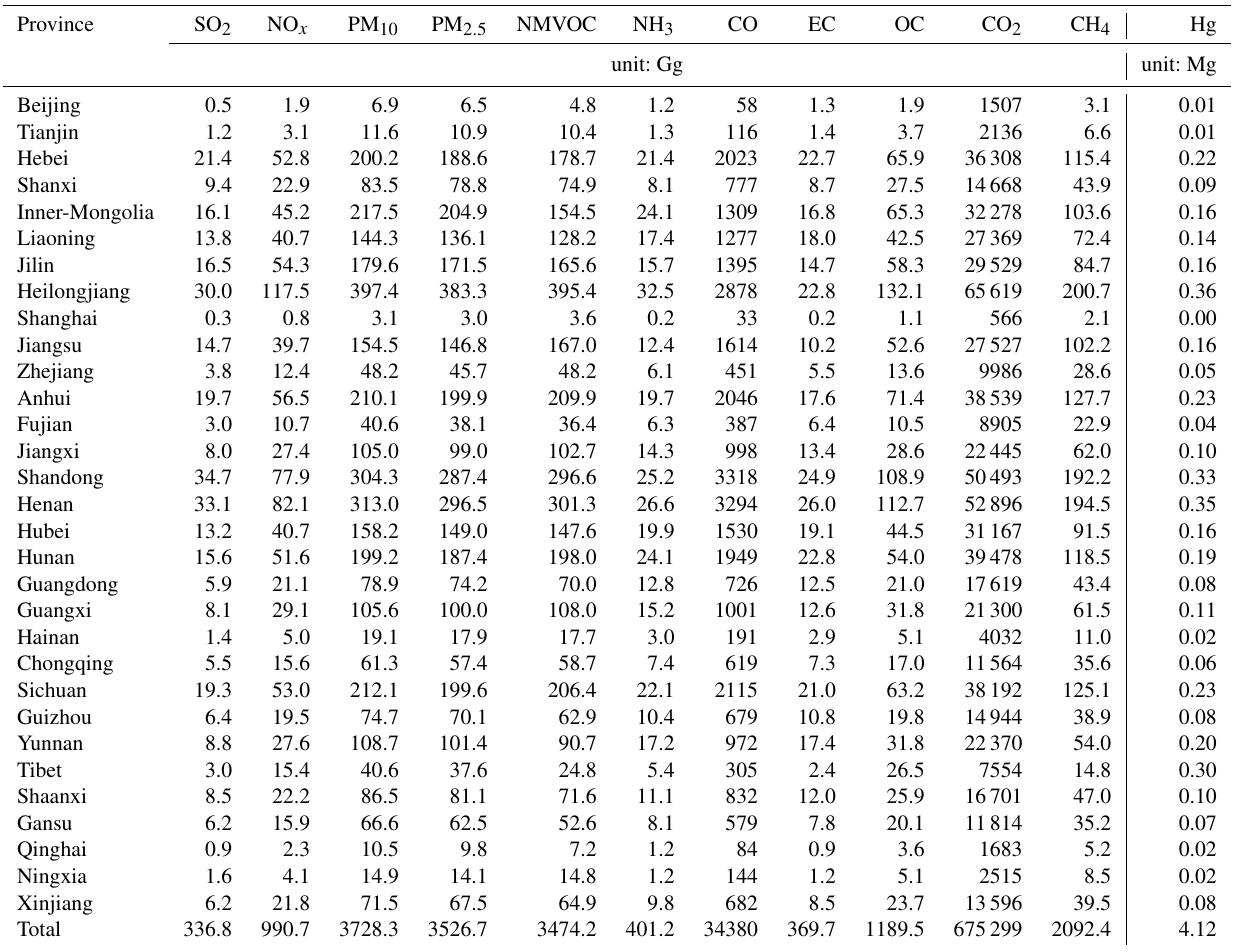
Table 7. Biomass burning emission inventory in the 31 provinces or municipalities of China in 2012. Province SO